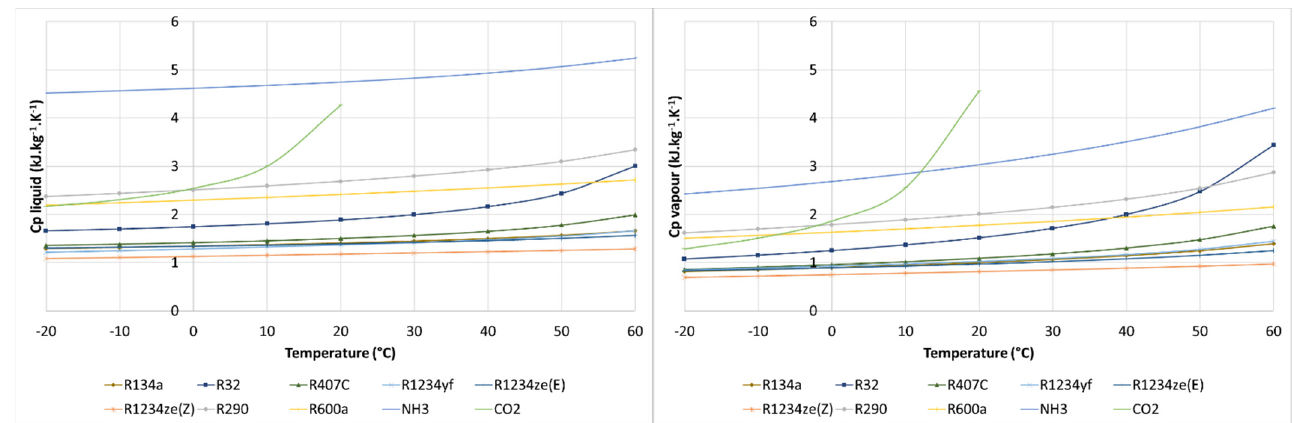
Figure 9. Comparison of evolutions of specific heat depending on temperature.